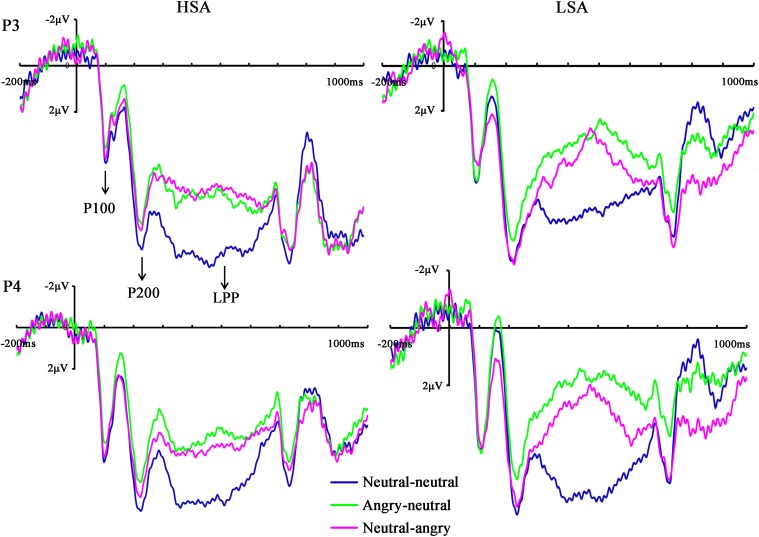
Grand mean ERPs in each facial emotional change condition at the left (P3) and right (P4) hemisphere electrodes with time windows of P100, P200, and LPP for HSA and LSA participants.